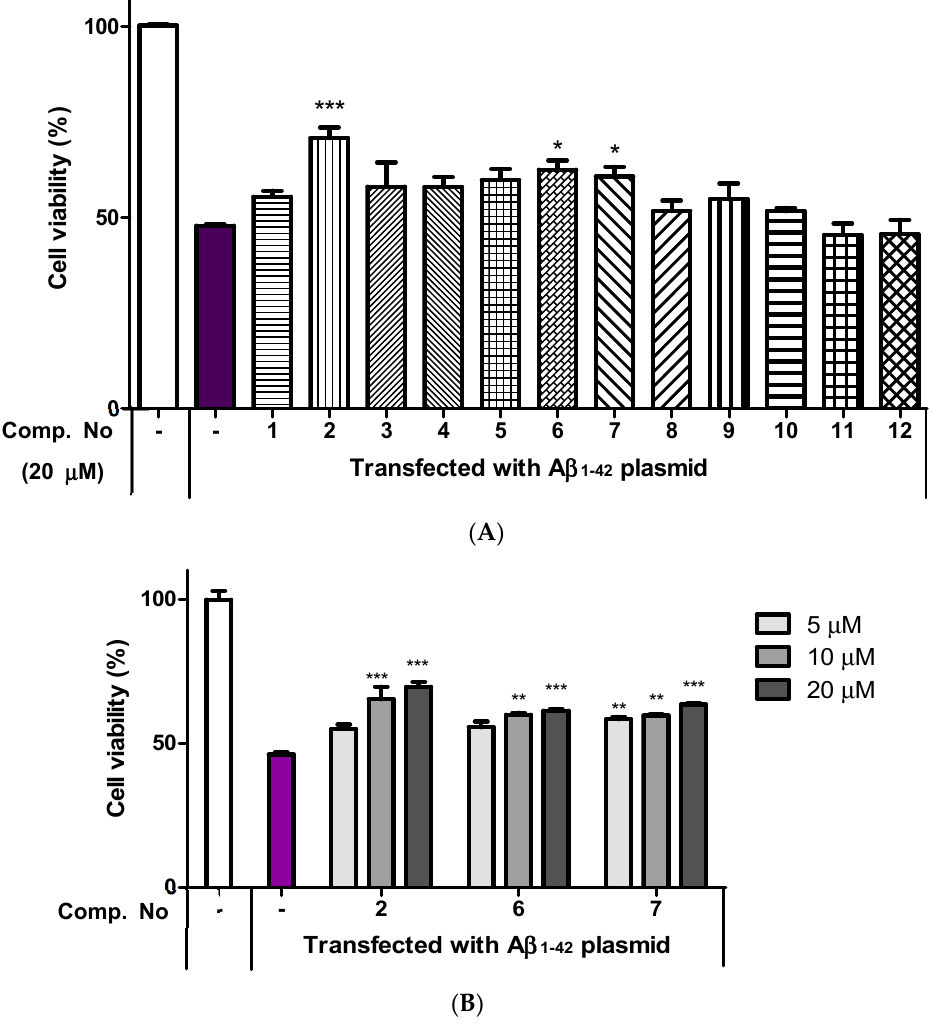
Figure 4. ( A ) Neuroprotective effects of compounds 1 – 12 against cytotoxicity induced by A β 42 plasmid transfection into HT22 cells. The cells were transfected with A β 42 plasmids for 10 h and treated with the test compounds at 20 μ M. ( B ) Neuroprotective effects of compounds 2 , 6 and 7 at different concentrations. After incubation for 24 h, cell viability was measured using the MTT assay. Each value was calculated as the mean ± SD ( n = 3); * p < 0.05, ** p < 0.01, *** p < 0.001 compared with the untreated A β 42 transfection group.